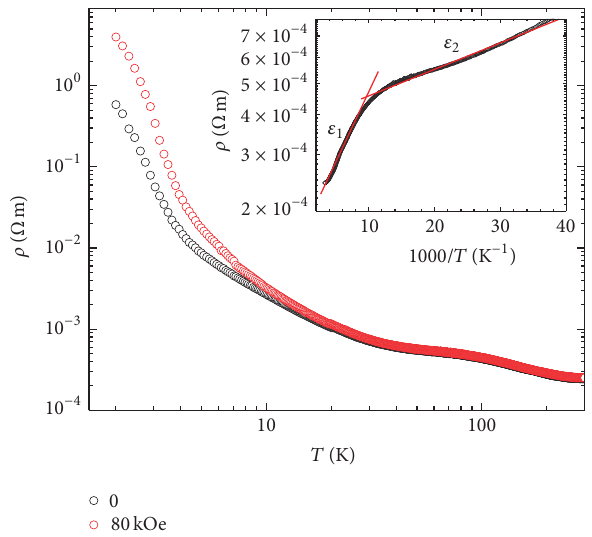
Figure 1: Temperature dependence of the resistivity at 𝐻 = 0 (black circles) and 𝐻 = 80 kOe (red circles) in the range 2–300 K. Inset: resistivity versus 𝑇 −1 (symbols). Experimental data are explained by two activation energies, 𝜖 1 ≈ 10.35 meV for 110–300 K and 𝜖 2 ≈ 1.73 meV for 28–90